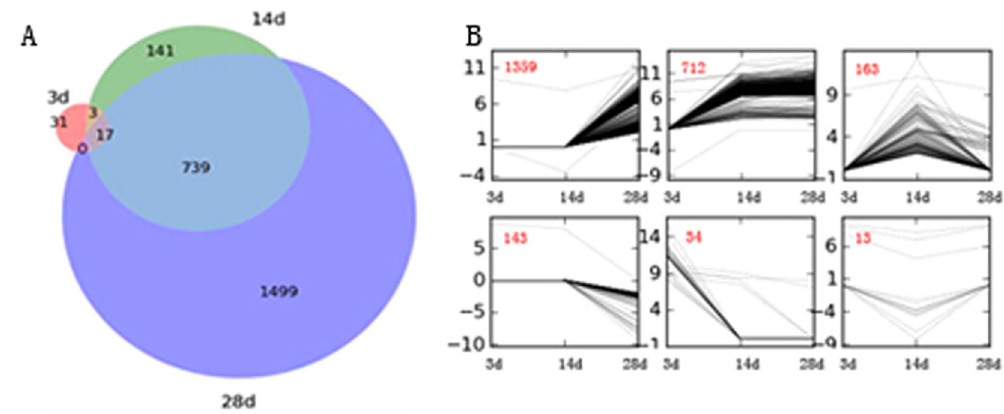
Figure 2. The DEUs and clustering analysis of the DEUs. ( A ) The Venn diagrams of DEUs at 3d, 14d and 28d treatment. ( B ) The clustering analysis of DEUs. The black lines show expression patterns. The red numbers on the left top represent the number of DEUs in each cluster. X-axis represents the treatment time (3d, 14d and 28d). Y-axis represents the log2 fold change compared with